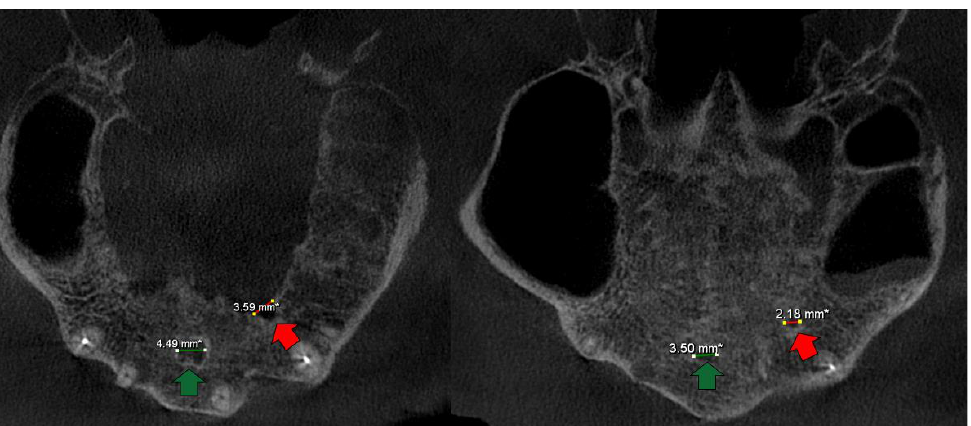
Figure 3. Radiological examination pattern of the AC diameter ( blue line ), AC distance to the buccal cortical plate ( green line ), and AC distance to the crest of the alveolar ridge ( red line ).